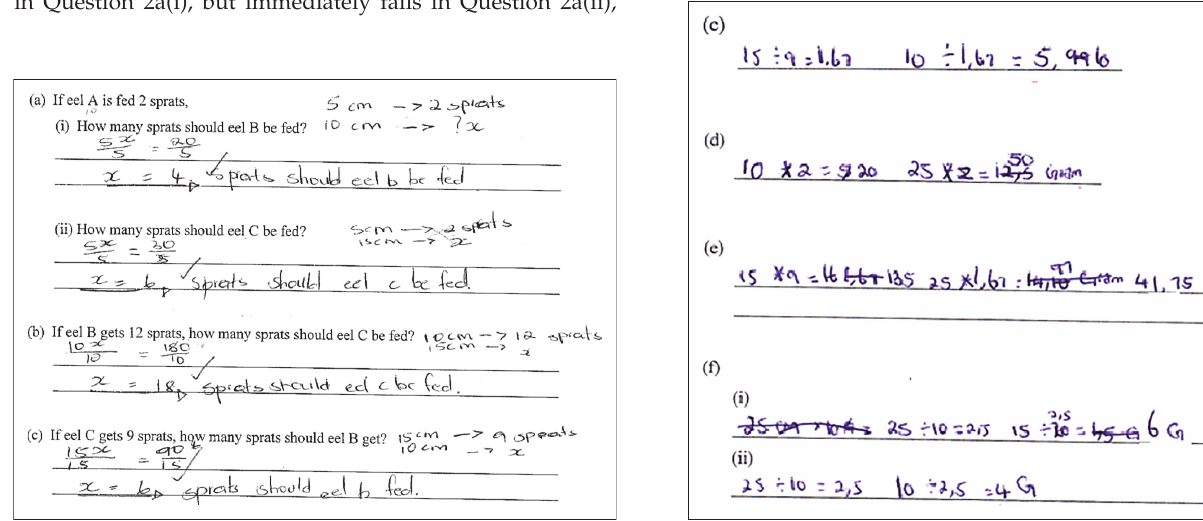
FIGURE 7: Responses of Learner 14 to Question 2. FIGURE 8: Response of Learner 16 to Question